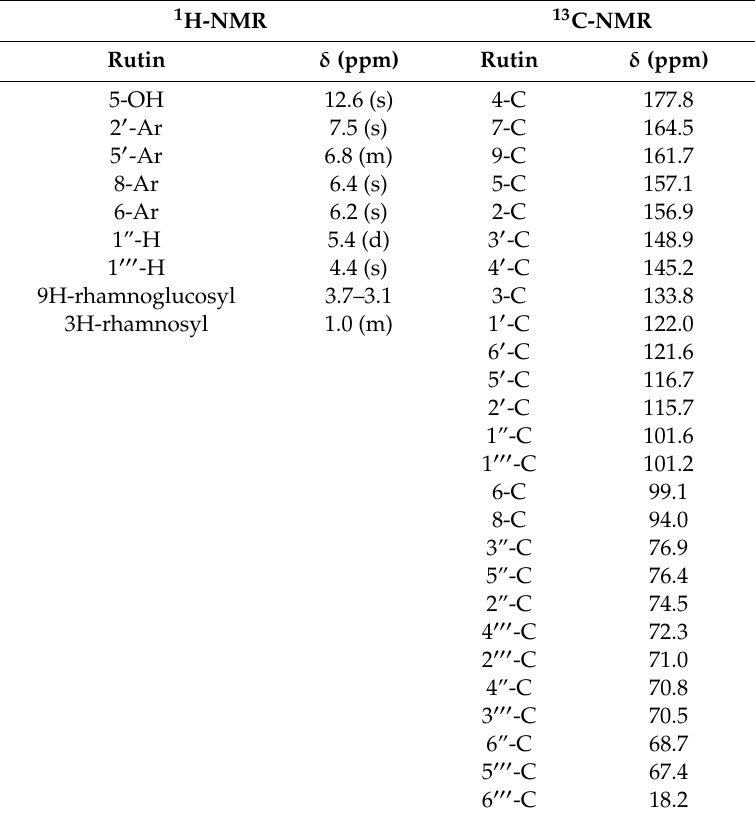
Table 1. 1 H Nuclear Magnetic Resonance (NMR) and 13 C-NMR profile of RUT (DMSO- d 6 , δ , multiplicity).